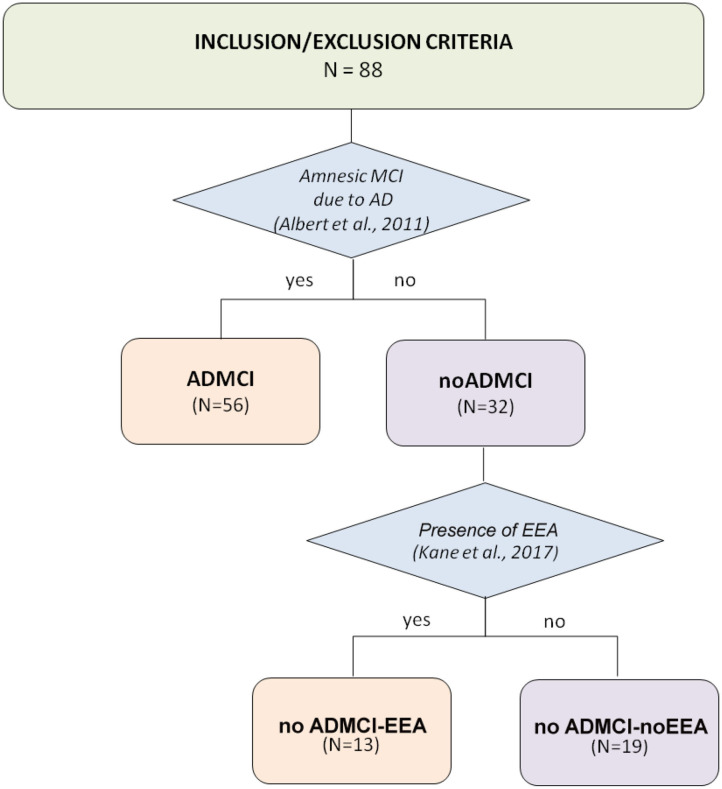
Flow chart illustrating the selection of patients with mild cognitive impairment not due to Alzheimer's disease (noADMCI) from the national (Italian) database of the present Consortium. This archive included 88 amnesic MCI patients: 56 patients with mild cognitive impairment due to Alzheimer's disease (ADMCI), and 32 noADMCI patients. These amnesic MCI patients were recruited by the following qualified Italian clinical units: the Sapienza University of Rome, Institute for Research and Evidence-based Cure (IRCCS) Fatebenefratelli of Brescia, IRCCS SDN of Naples, IRCCS Oasi Maria SS of Troina, University of Genova, Hospital San Raffaele of Cassino, and IRCCS San Raffaele Pisana of Rome.